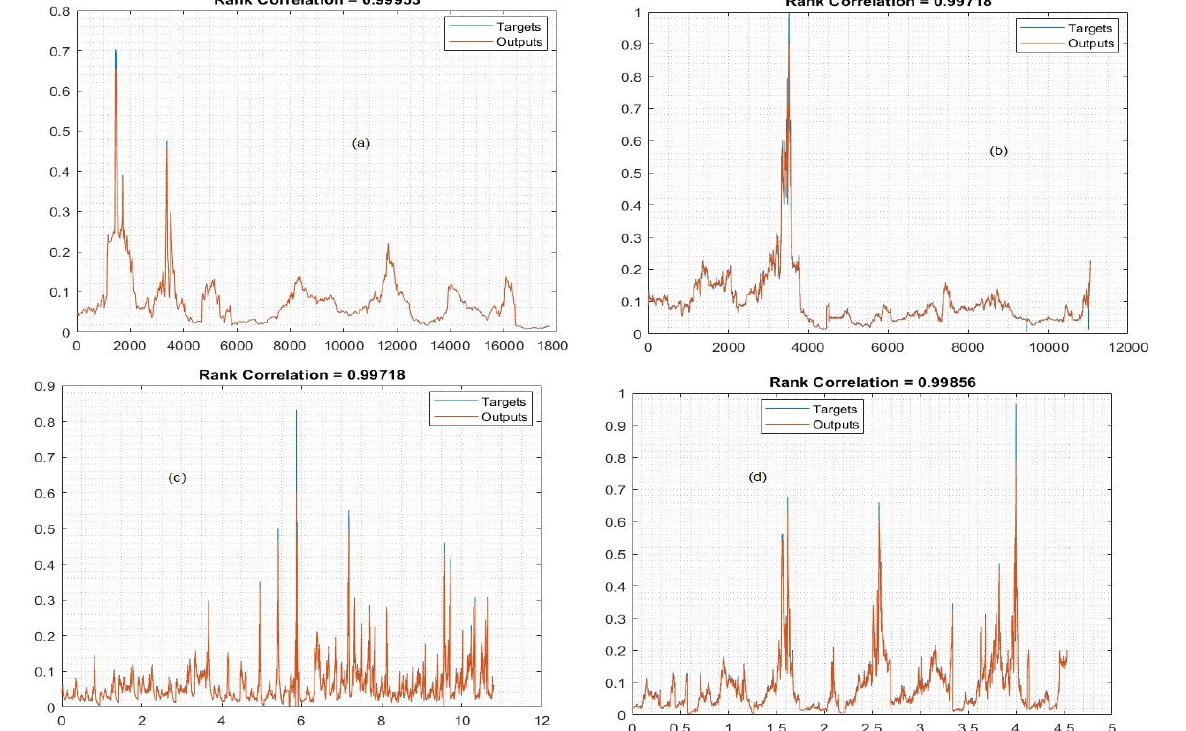
Figure 10. Prediction plot of the MLP model in the training process, ( a ) communication ( b ) energy, ( c ) financial and ( d ) industrial sectors. ( c ) financial and ( d ) industrial sectors.